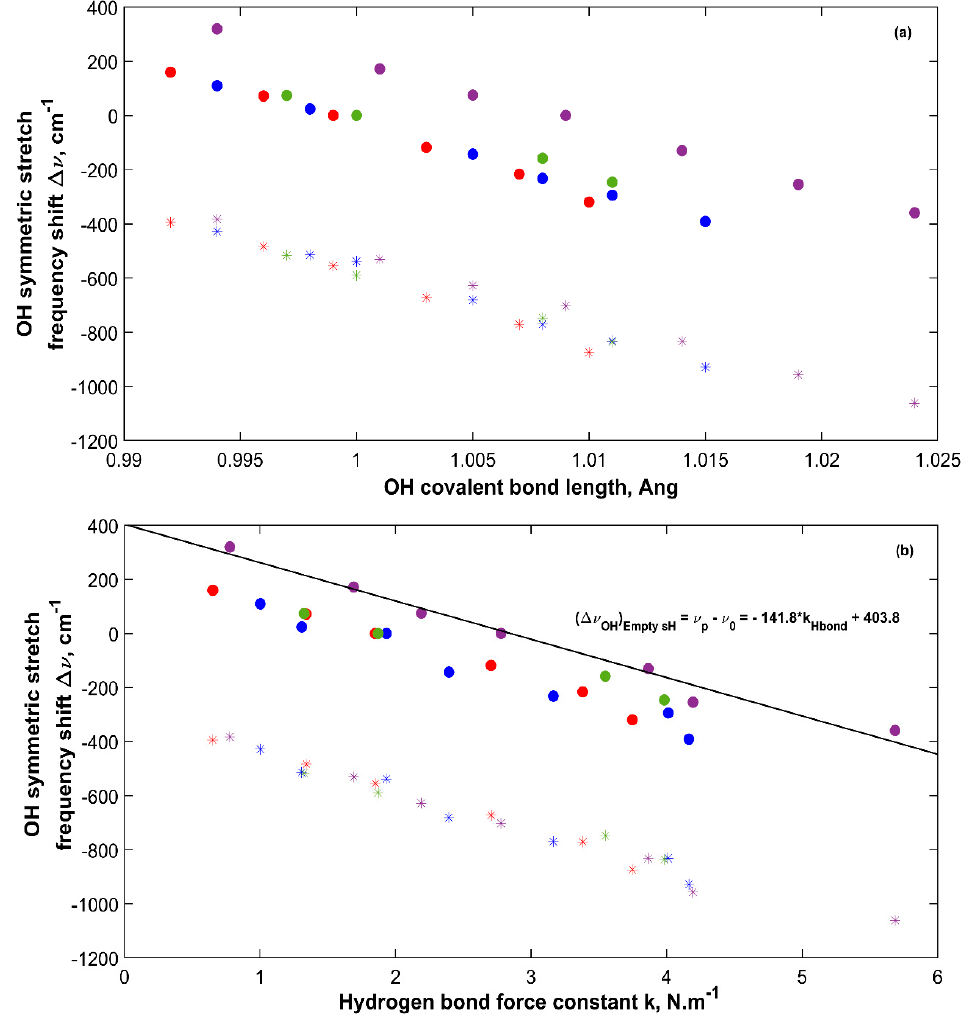
Figure 10. OH symmetric stretching frequency shift ∆ ν of sH hydrates versus OH covalent bond length ( a ) and versus hydrogen bond force constant ( b ). ( • ) computed shift with system at equilibrium as a reference. ( * ) computed shift with water vapor as a reference. Color code: empty sH (purple), Xe-NH sH (blue), CO 2 -NH sH (red), CO 2 -CH 4 -NH sH (green).